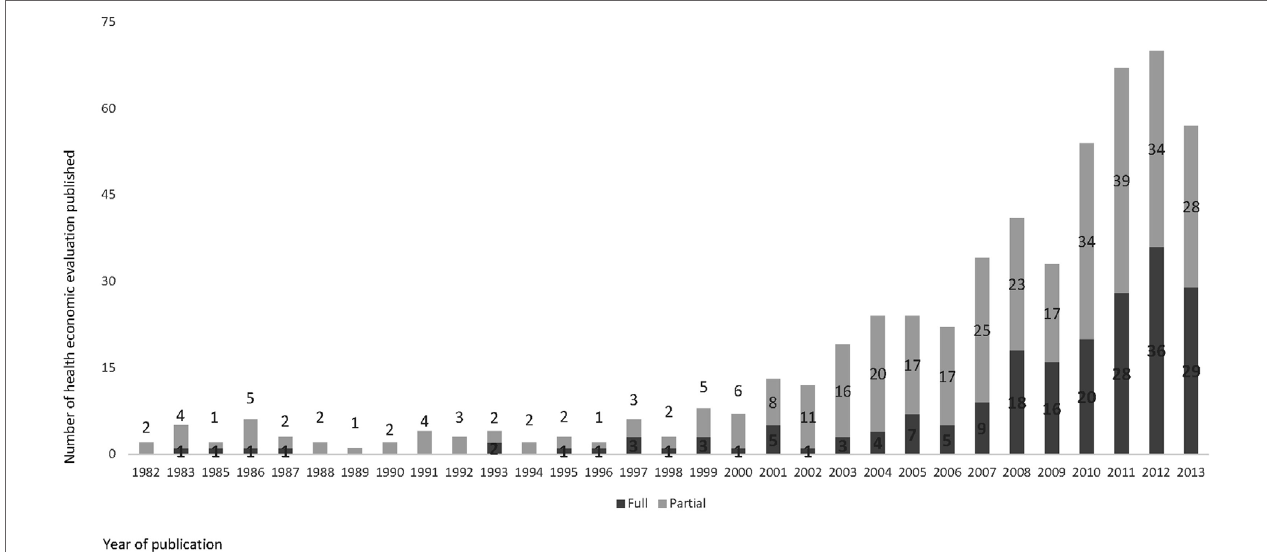
FiGURe 2 | Number of health economic evaluation studies in Brazil, by type,